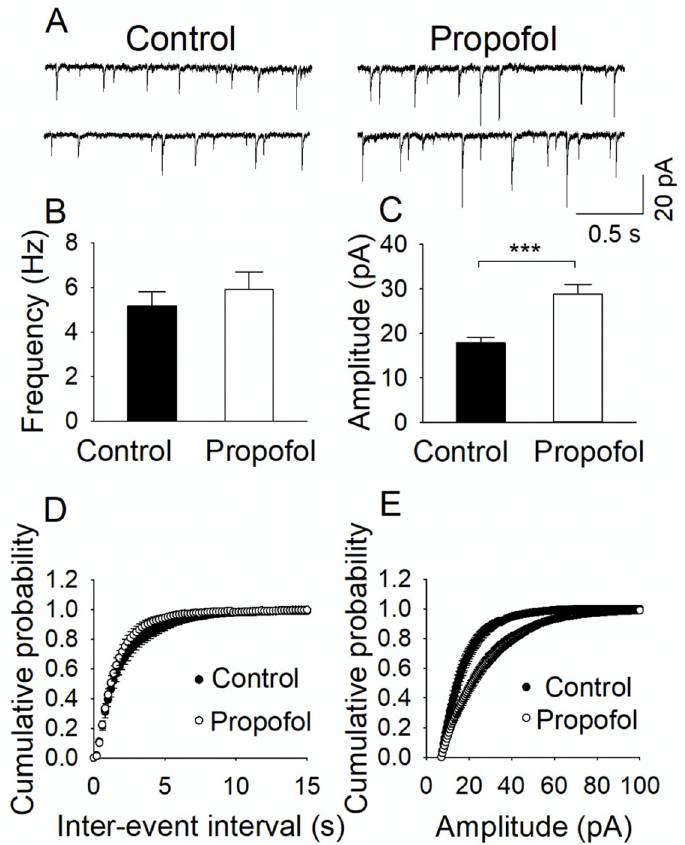
Figure 4. Propofol exposure led to an increase of inhibition in P60 mouse hippocampal neurons. ( A ) Example of miniature inhibitory postsynaptic current (mIPSC) traces. ( B ) The mean frequency of mIPSCs was not significantly changed in propofol group (n = 9–10; t 17 = 0.766, p = 0.454). ( C ) Propofol exposure increased the mean amplitude of mIPSCs (t 17 =4.380, *** p < 0.001). ( D , E ) Propofol did not influence the distribution of mIPSC inter-event interval values but resulted in a right shift of the cumulative amplitude distribution (n = 9–10; p < 0.01). Data from all events were averaged and